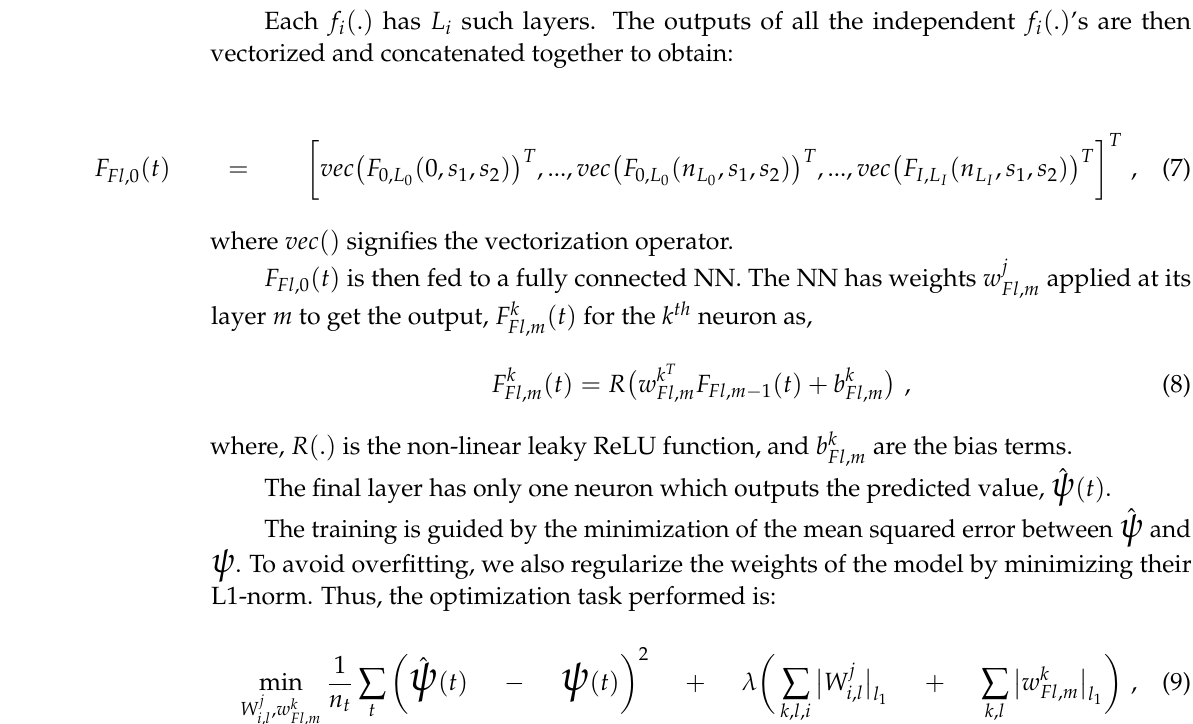
Figure 1. Architecture showing feature level